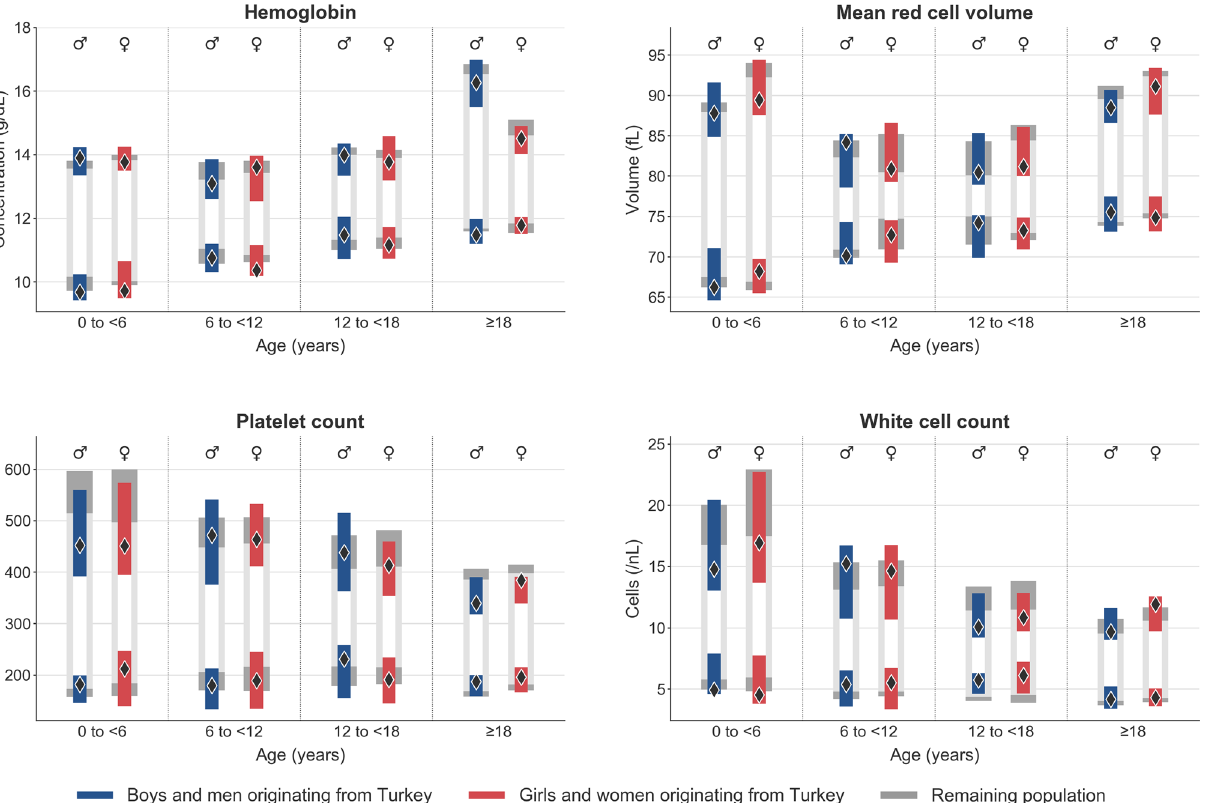
Figure 2. Reference intervals of hemoglobin, mean red cell volume, platelet count, and white cell count for individuals originating from Turkey. Reference intervals and 90% confidence intervals for individuals originating from Turkey (black diamonds denote male and female reference limits and blue and red bars denote the respective 90% confidence intervals) in comparison to the remaining population (dark-gray bars in the background denote reference limits’ confidence intervals). The exact numerical values of the reference intervals and confidence intervals are available in Supplemental Tables S2 and S3. For Red cell count, hematocrit, mean corpuscular hemoglobin (MCH), mean corpuscular hemoglobin concentration (MCHC), and red cell distribution width (RDW) see Supplemental Fig.